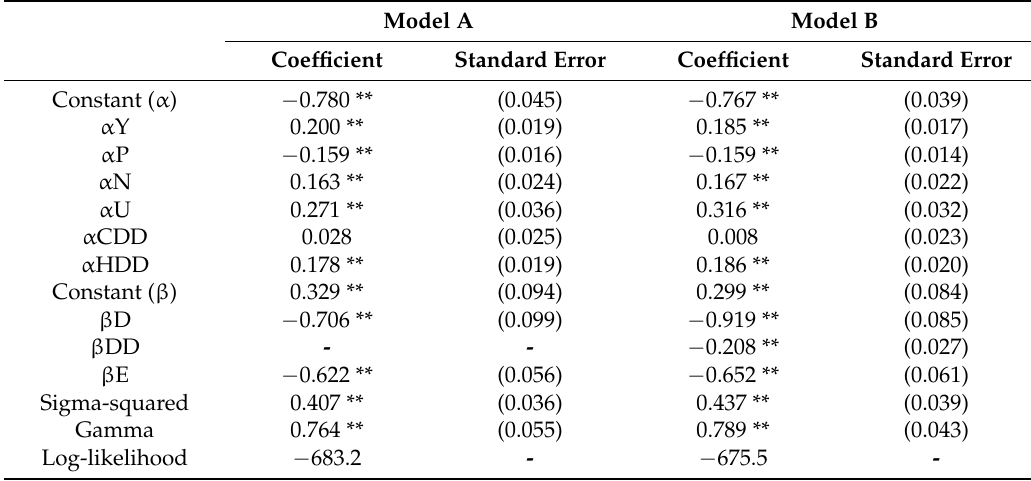
Table 3. Estimation